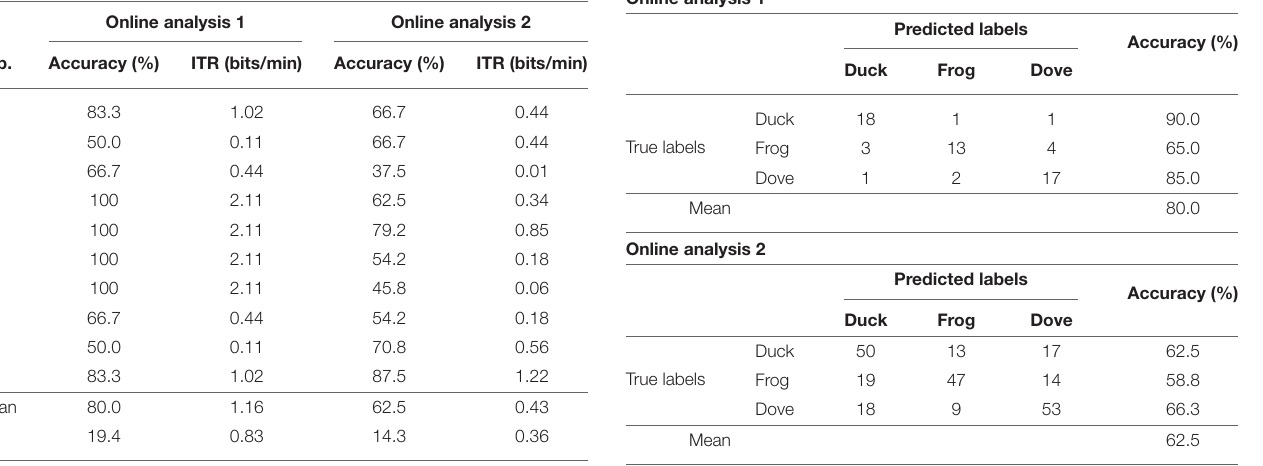
TABLE 4 | Summary of detection performances in online analyses for which the average accuracy of online analysis 1 was 80.0% with an ITR of 1.16 bits/min and that of online analysis 2 was 60.0% with an ITR of 0.44 bits/min.